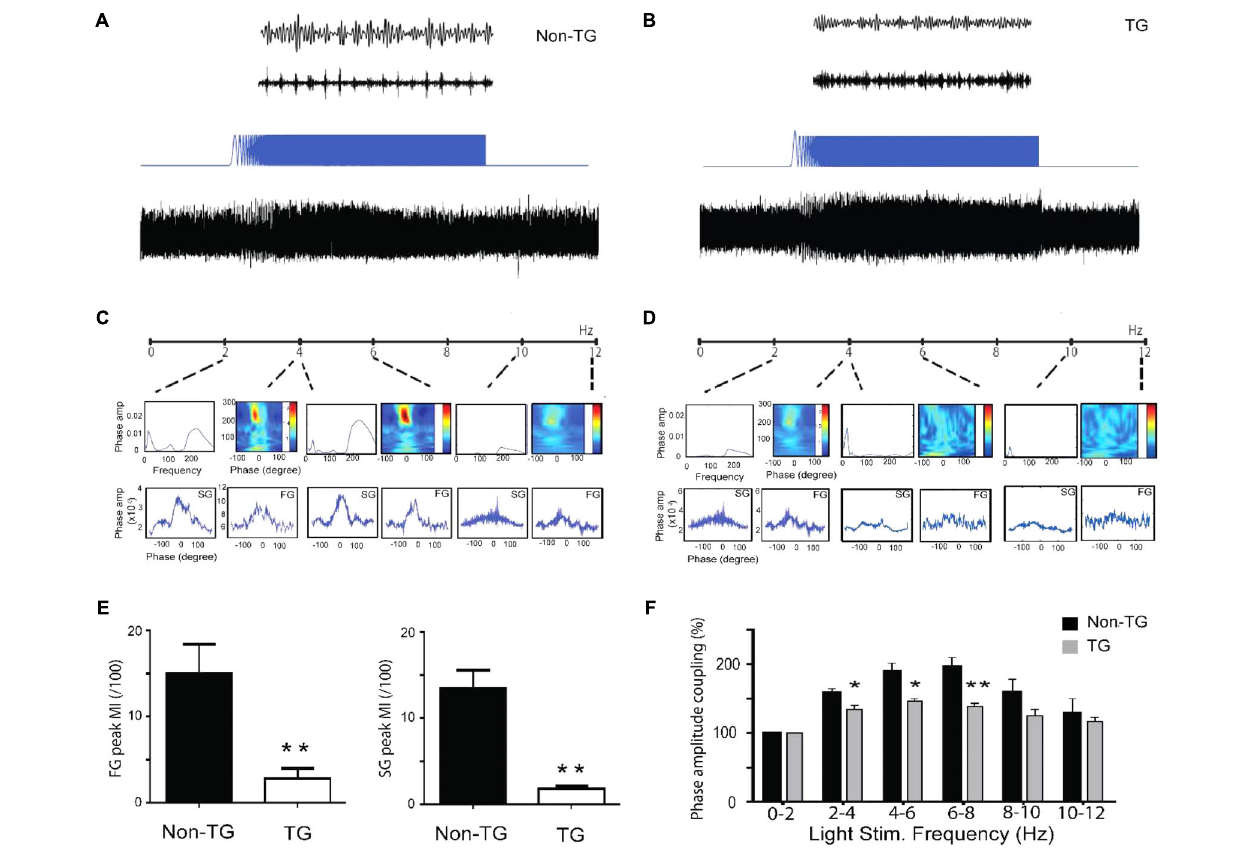
FIGURE 7 | Altered oscillatory activity properties under optogenetic activation of PV neurons in hippocampus networks. Sample traces from Non-TG mice (A) and TG mice (B) showing 8 Hz (theta) light stimulation of hippocampal PV neurons with Cheta virus expression. Theta traces was then filtered at the 35–45 Hz slow gamma and 180–200 Hz fast gamma range. By using linear increase of the stimulation frequency from 0 to 12 Hz (ZAP protocol), both Non-TG and TG network oscillation can be evoked from 0 to 12 Hz (A,B) . Theta-gamma coupling properties are evaluated at different frequency range from both groups (C,D) . Summary graph showing the modulation index of FG and SG from TG are significantly lower than the Non-TG group (E) , ( t -test, n = 5 in each group, p < 0.05). The TG group displayed reduced theta power at frequency range of 2–4 Hz, 4–6 Hz, and 6–8 Hz, compare to Non-TG group (F) , two tailed t -test, n = 5 in each group, ∗ p < 0.05, ∗∗ p <